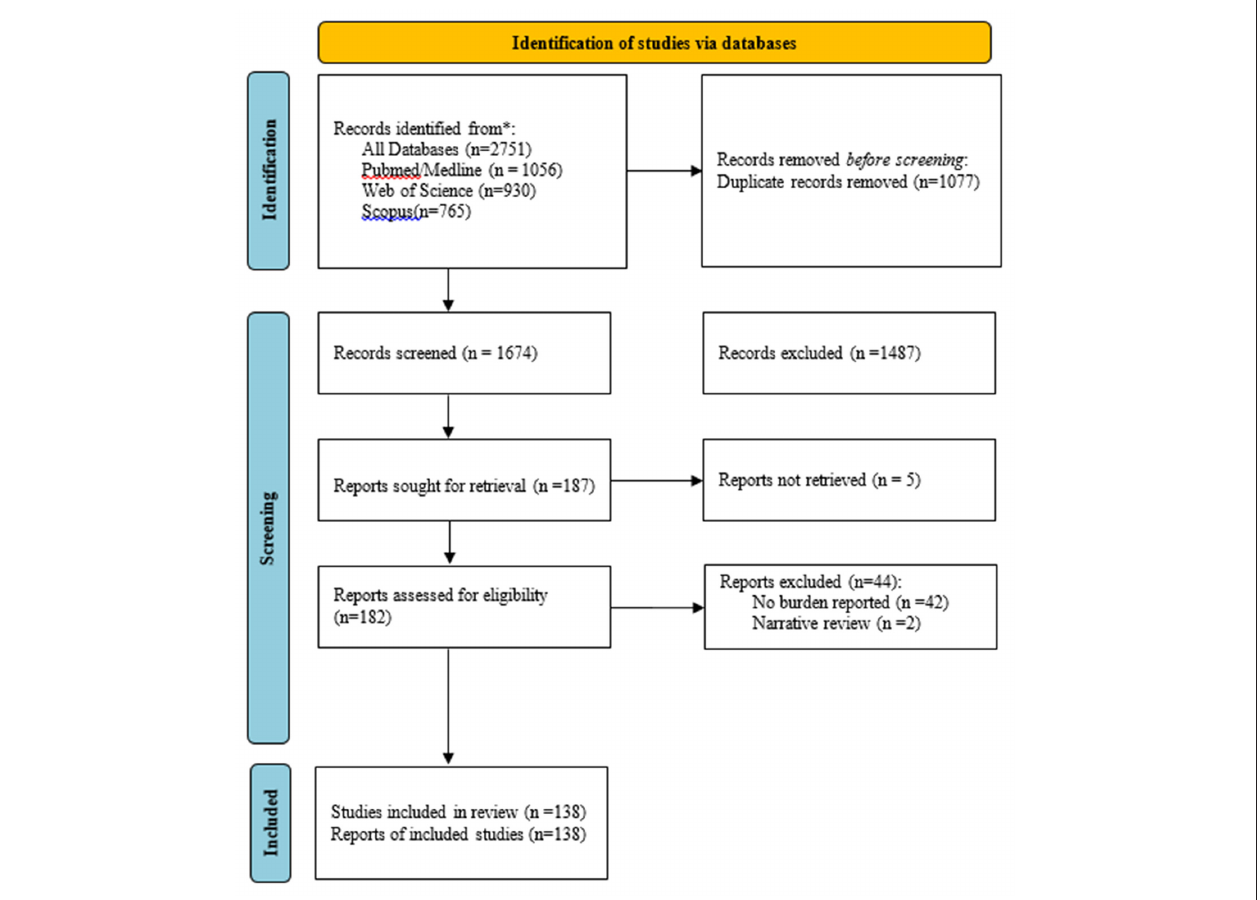
FIGURE 1 | PRISMA flow chart showing the number of studies included in a scoping review for breast, cervical and prostate cancer in Sub-Saharan Africa.